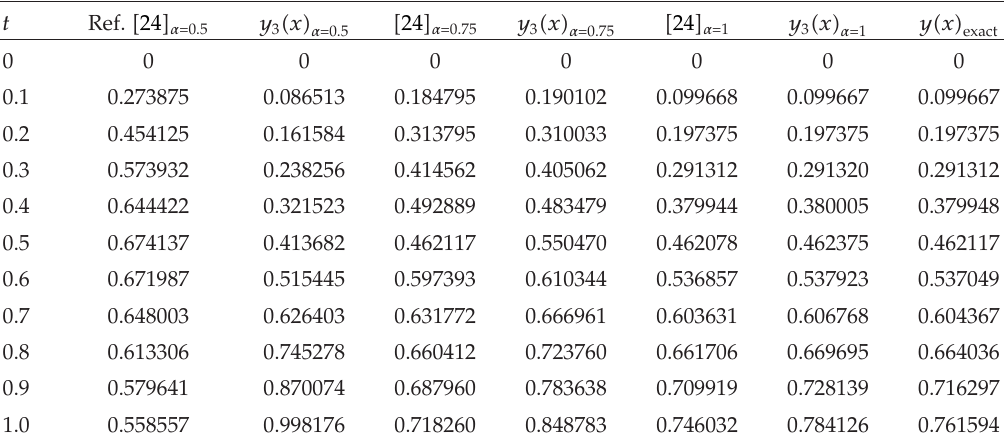
Table 1: Approximate solutions for (cid:3) 4.1 (cid:4)